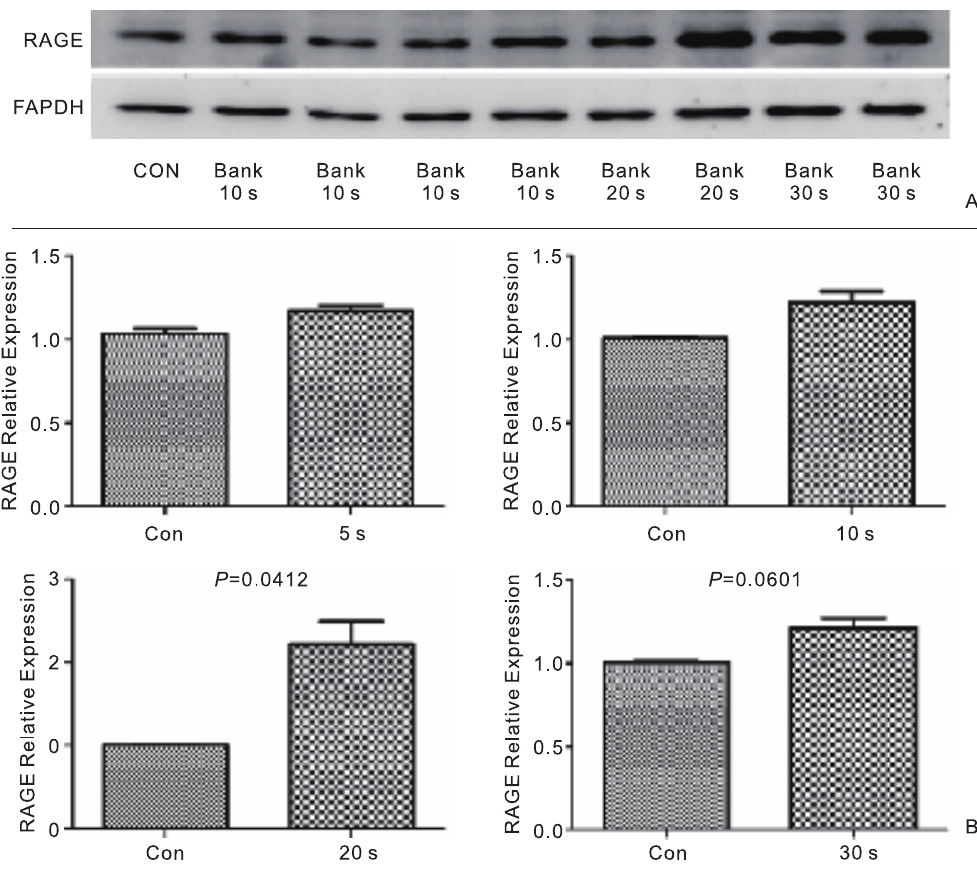
Figure 2 Western-blot analysis showed expression of RAGE in suspended cell group. (A) Expression change of RAGE at various times; (B) Inductions of RAGE relative expression at 5, 10, 20 and 30 s were potted by column graph, respectively. The error bars represented the standard deviation ( n =3). Statistically significant differences were indicated with p values. Con (HCAEC only), Blank (HCAEC+SonoVue microbubble) and RAGE (HCAEC+ SonoVue microbubble+ RAGE plasmid), Con and Blank served as the internal control.